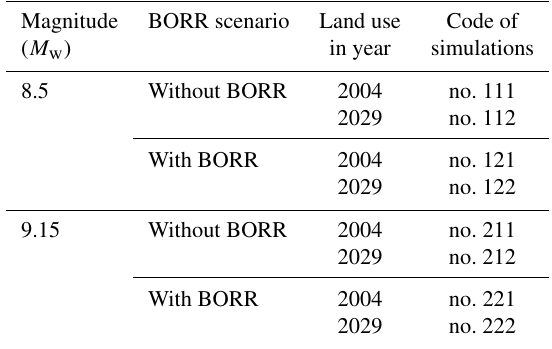
Table 2. Scenarios of the numerical simulations.